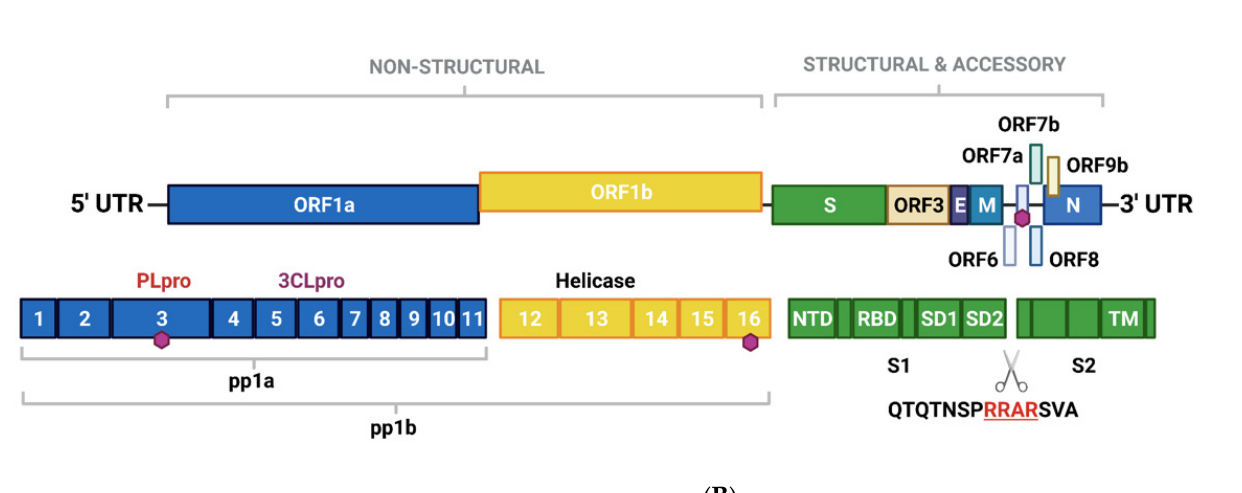
Figure 1. Overview of the SARS-CoV-2 viral life cycle and structural organization . ( A ) SARS- CoV-2 comprises four structural proteins—the envelope (E) and membrane (M) proteins encase the single-stranded RNA and nucleocapsid (N). The spike (S) protein is made up of S1 and S2 subunits and facilitates receptor binding in the host cell. In humans, this is ACE2, in synergy with TMPRSS2 (orange box). SARS-CoV-2 binds to ACE2 on respiratory epithelial cells through the receptor bind- ing domain on S. The SARS-CoV-2 viral particle is endocytosed following cleavage of S. SARS-CoV- 2 nucleocapsid, a complex of viral RNA and N protein, is released into the cytosol. The N protein is removed from the capsid, leaving naked viral RNA, which is a capped positive-stranded RNA mol- ecule that can immediately be translated to allow production of viral proteins (not shown). Viral